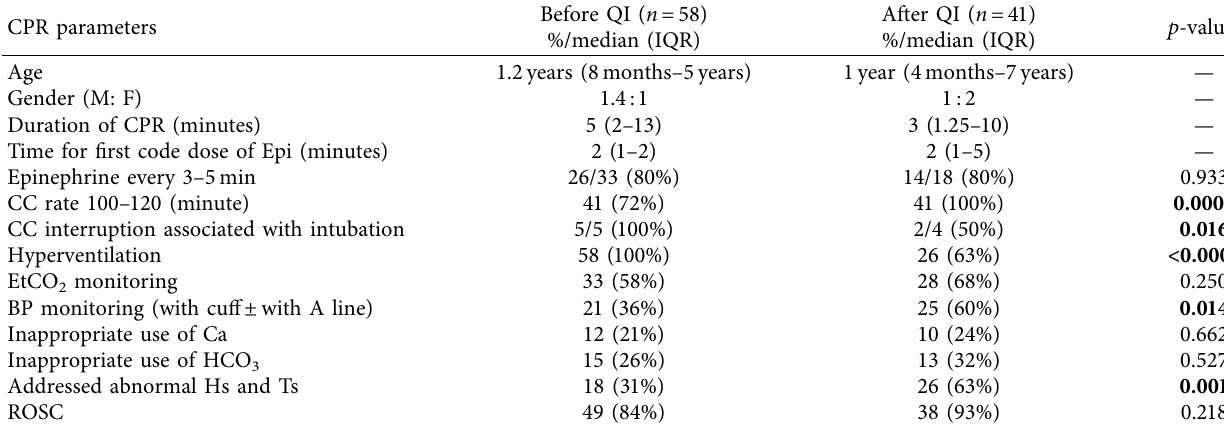
Table 2: Comparative CPR data before and after QI